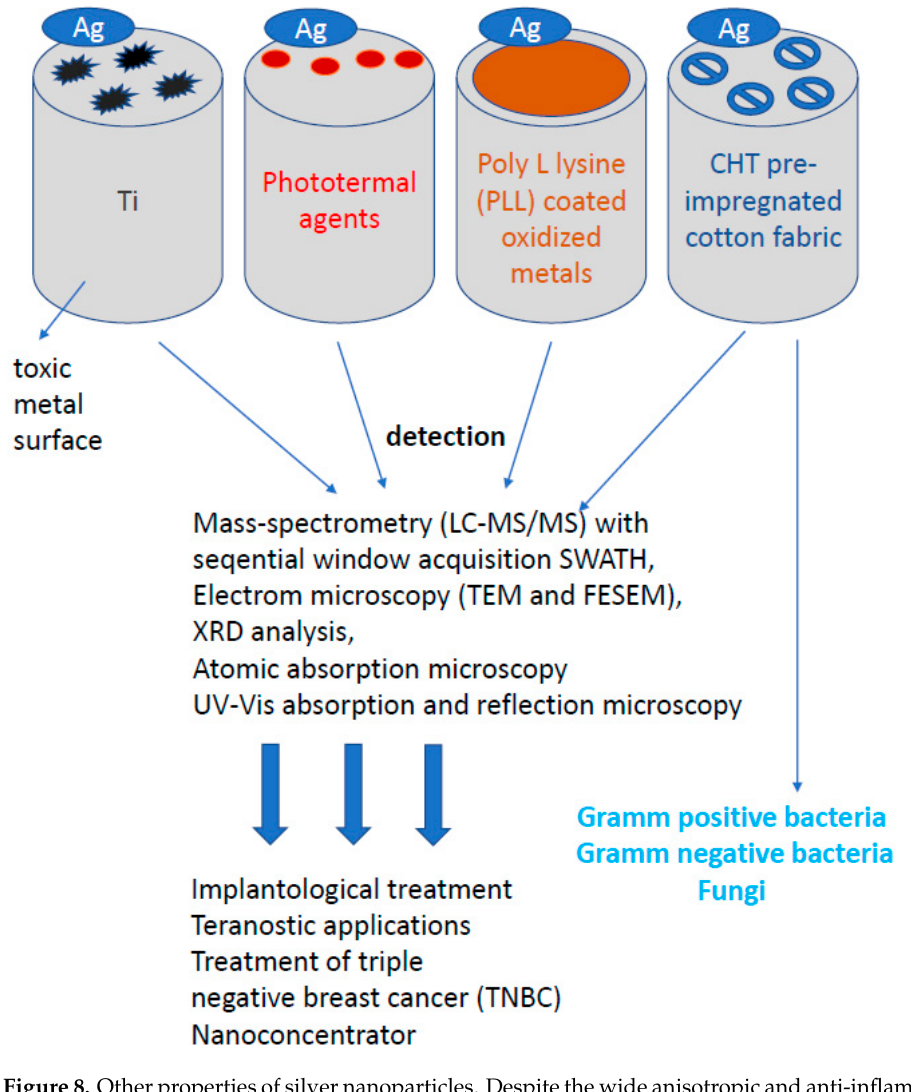
activity of that surface was tested against two different bacteria strains S. aureus and P. aureginosa (Figure 8). For both strains and different sizes of AgNP, the surface modified with PLL and AgNPs shows significantly enhanced antimicrobial activity compared to titanium deposited AgNPs by 5 rows relative to the original inoculum bacteria. That means that the relatively low AgNPs load on PLL-modified titanium surfaces reaches 99.999% of bacterial death after 24 h.